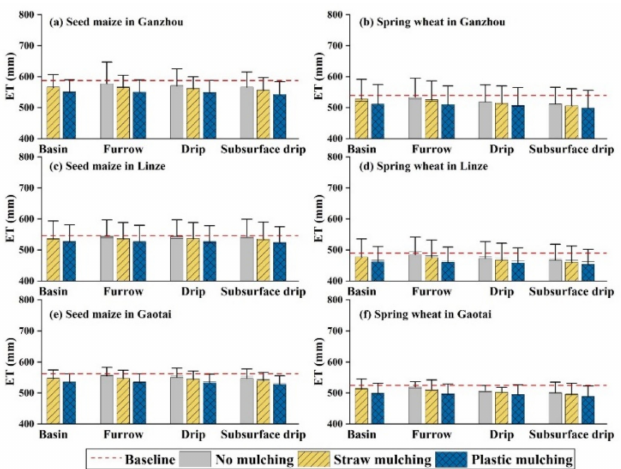
Figure 5. Comparisons of ET for seed maize in ( a ) Ganzhou, ( c ) Linze and ( e ) Gaotai, and spring wheat in ( b ) Ganzhou, ( d ) Linze and ( f ) Gaotai under different combinations of management